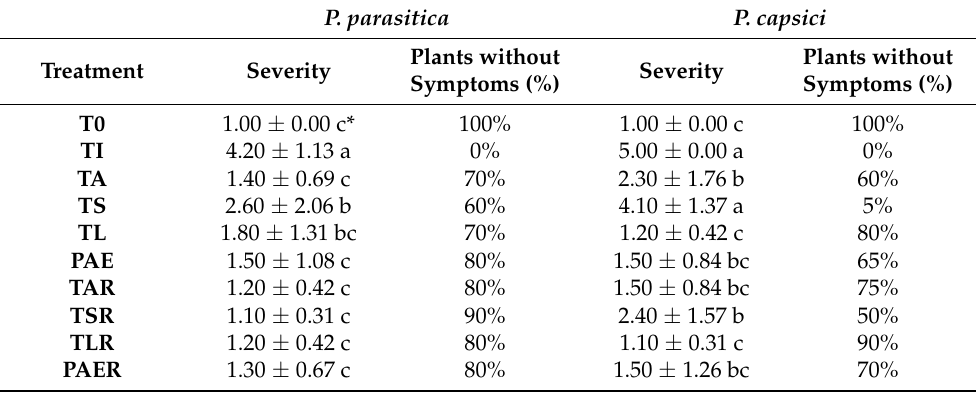
* Values in same column with different letters are significantly different according to one-way analysis of variance (ANOVA) followed by Tukey’s test at the 0.05 alpha level of confidence. Green: favourable; Orange: no effect compared to control. Table 3. Phytophthora parasitica and P. capsici disease severity in pepper inoculated with TA, TS, TL, or PAE (10 5 spores per plant) in two experiments in greenhouse conditions in which plants were inoculated with antagonist before the pathogen and before/after (reinoculated, R). All plants, except for controls (T0), were then inoculated with 5 mL of zoospore suspension (10 4 zoospores · mL − 1 ). Disease severity was assessed on a 1–5 scale, where 1 indicated free of infection (plants without symptoms) and 5 indicated dead